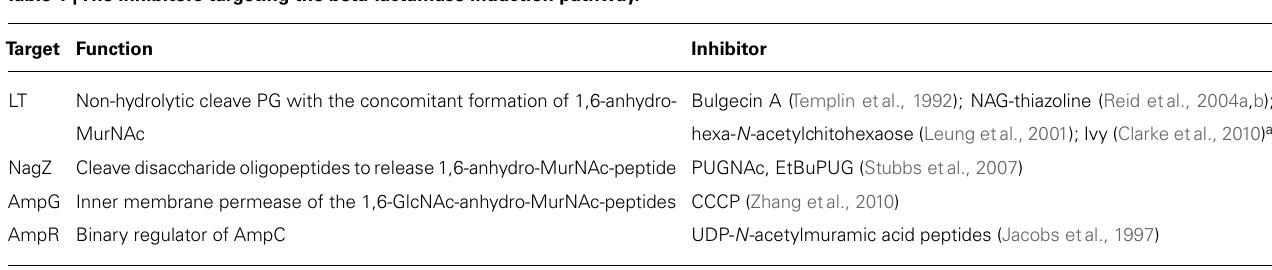
Table 1 |The inhibitors targeting the beta-lactamase induction pathway. Target Function